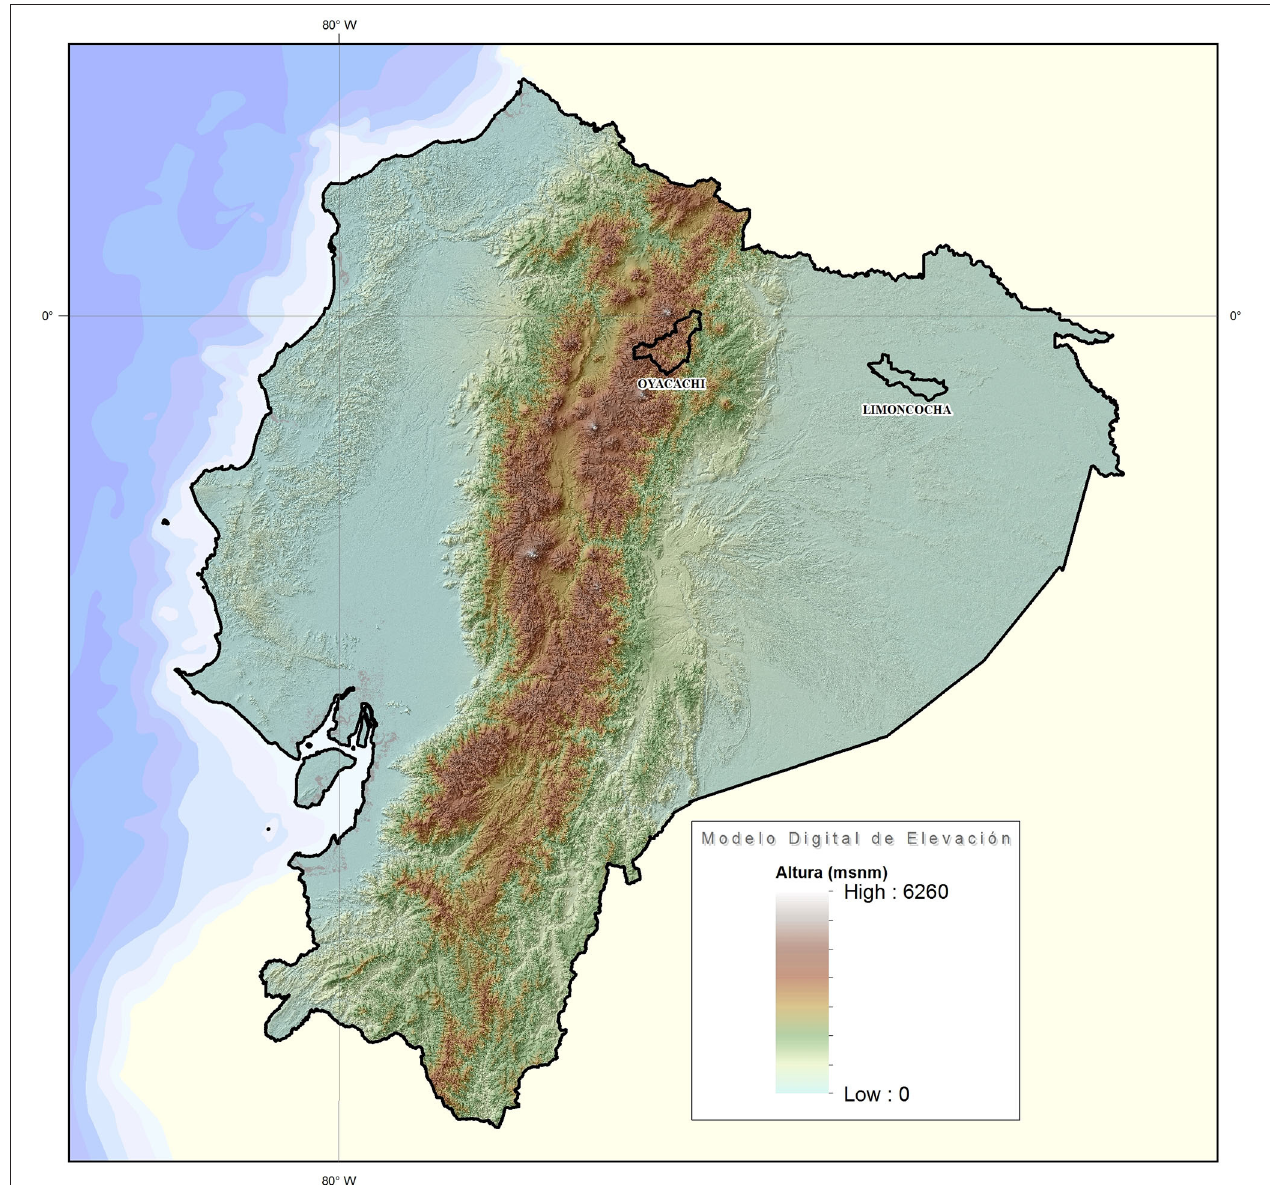
FIGURE 1 | Vital signs differences according to sex and